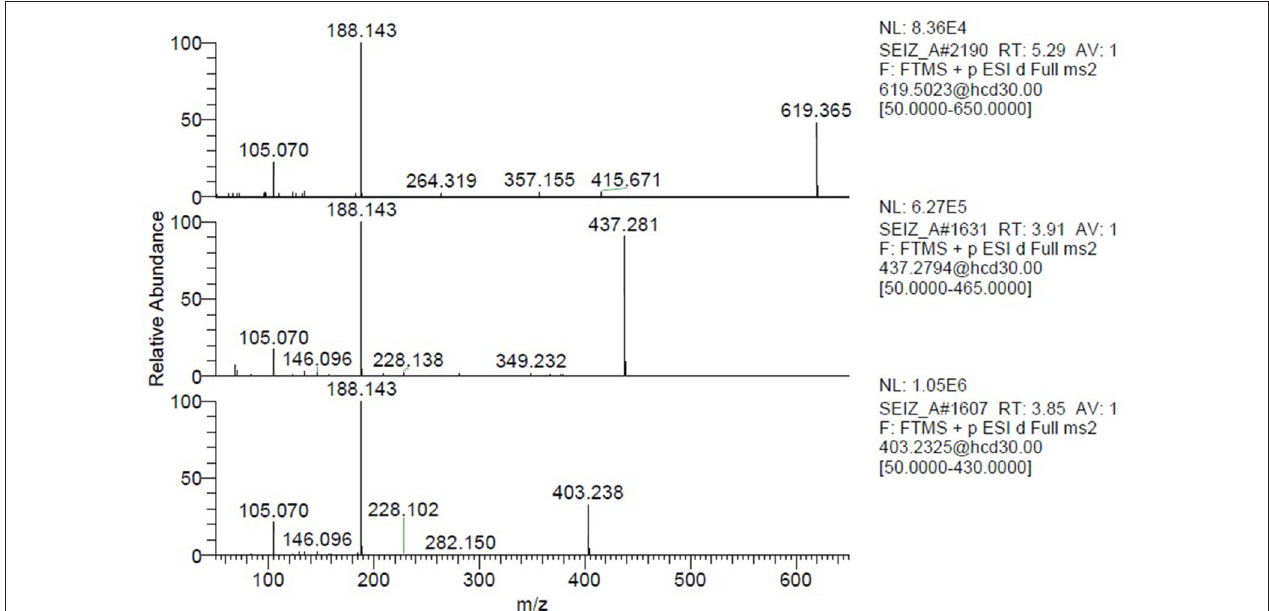
FIGURE 4 | MS/MS spectra of the two nodes with precursor m/z = 351.243.